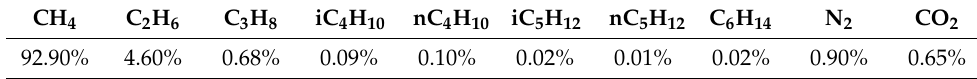
Table 2. Natural gas reference molar composition (main